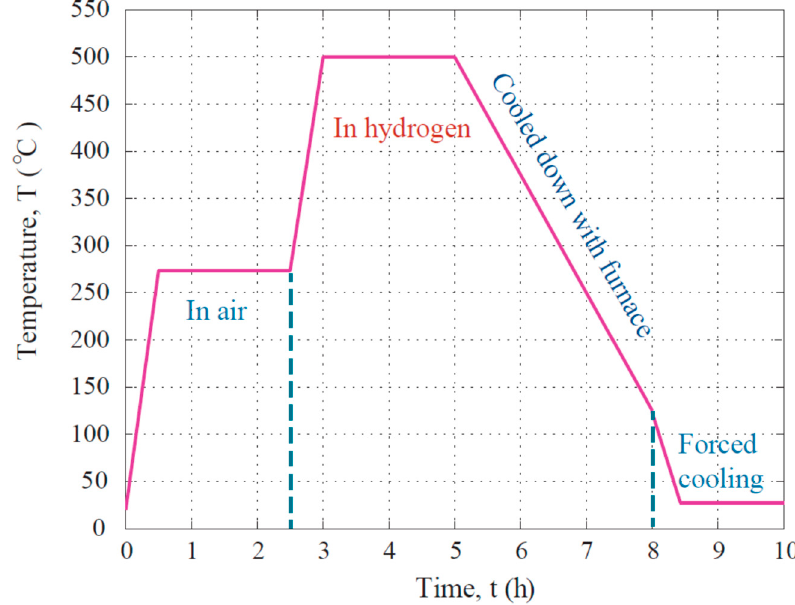
Figure 2. Time-temperature profile associated with the heat treatment on the spun fibers.